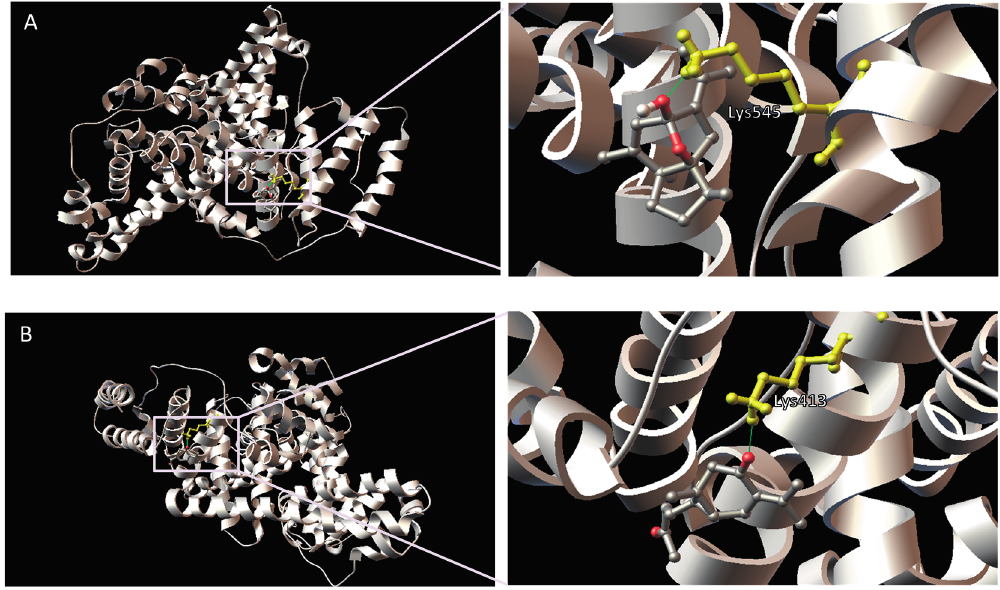
Figure 8. Predicted orientations of the lowest docking energy conformations of 1BM0-ligand complexes. The binding sites were enlarged to show hydrogen bonding (green lines) between amino acid residues and the ligands. Amino acid residues that form hydrogen bonds with the ligands are rendered in ball and stick and colored yellow. ( A ) Curcumenol in the binding site II of HSA (1BM0); ( B ) Curcumenone in the binding site II of HSA